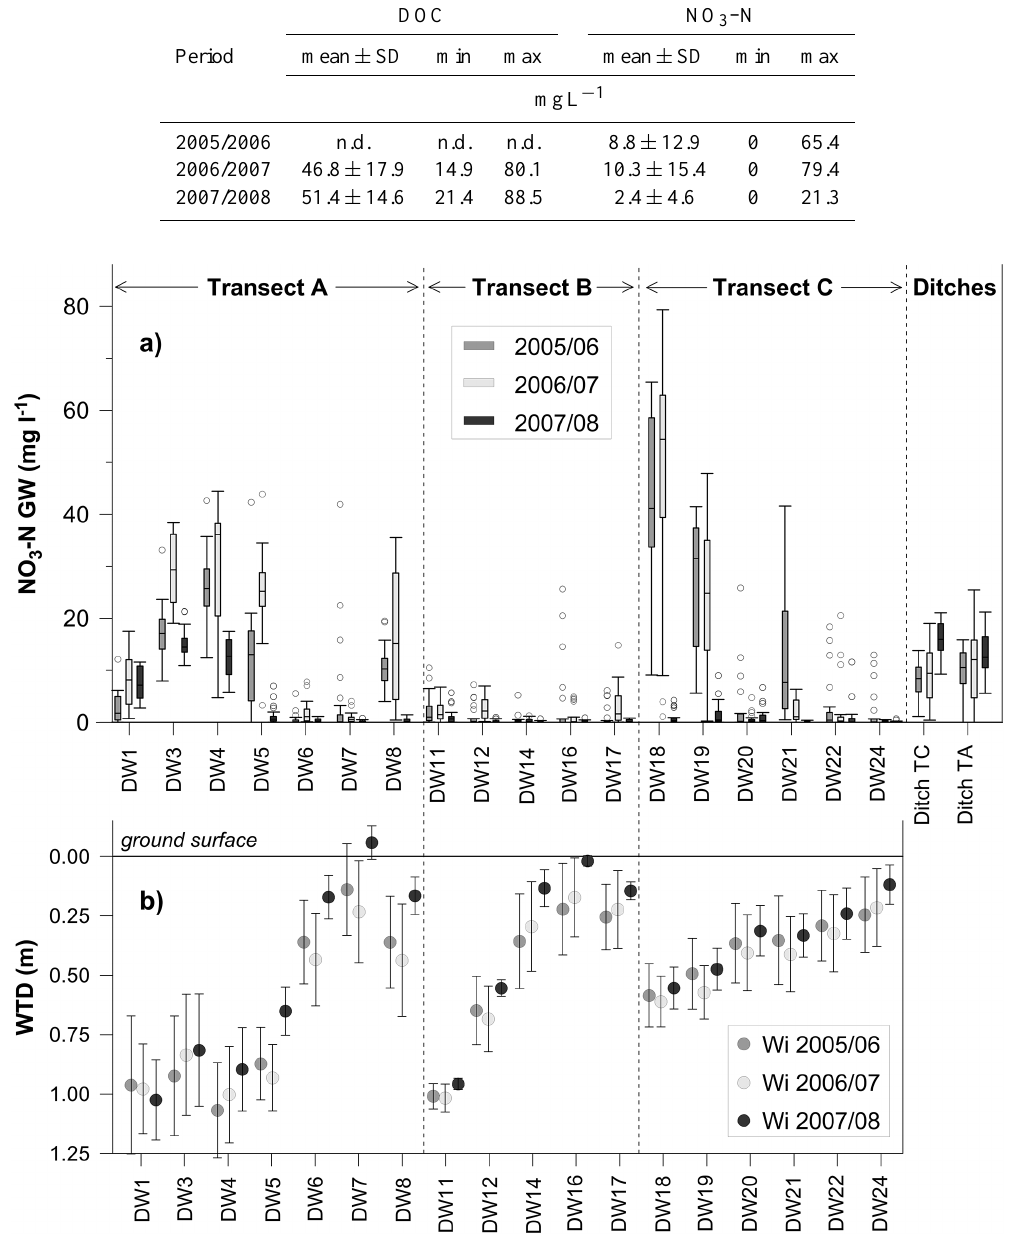
Figure 4. (a) Spatial and temporal variability of nitrate–nitrogen (NO 3 –N) concentrations in the dip wells. (b) Mean and standard deviation of the water table depth (WTD) during winter. Only sampled dip wells are